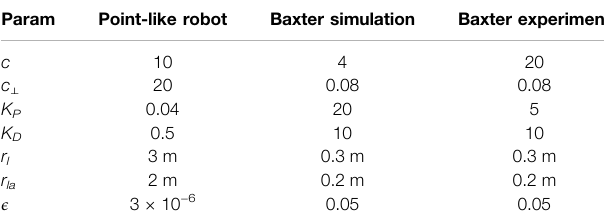
FIGURE 6 | The averaging technique employed to post-process the sensory information can be used to solve the problem of a concave sharp cornerwhere (A) thecurvaturesurfaceisdiscontinuousand (B) therearenon- unique closest points.